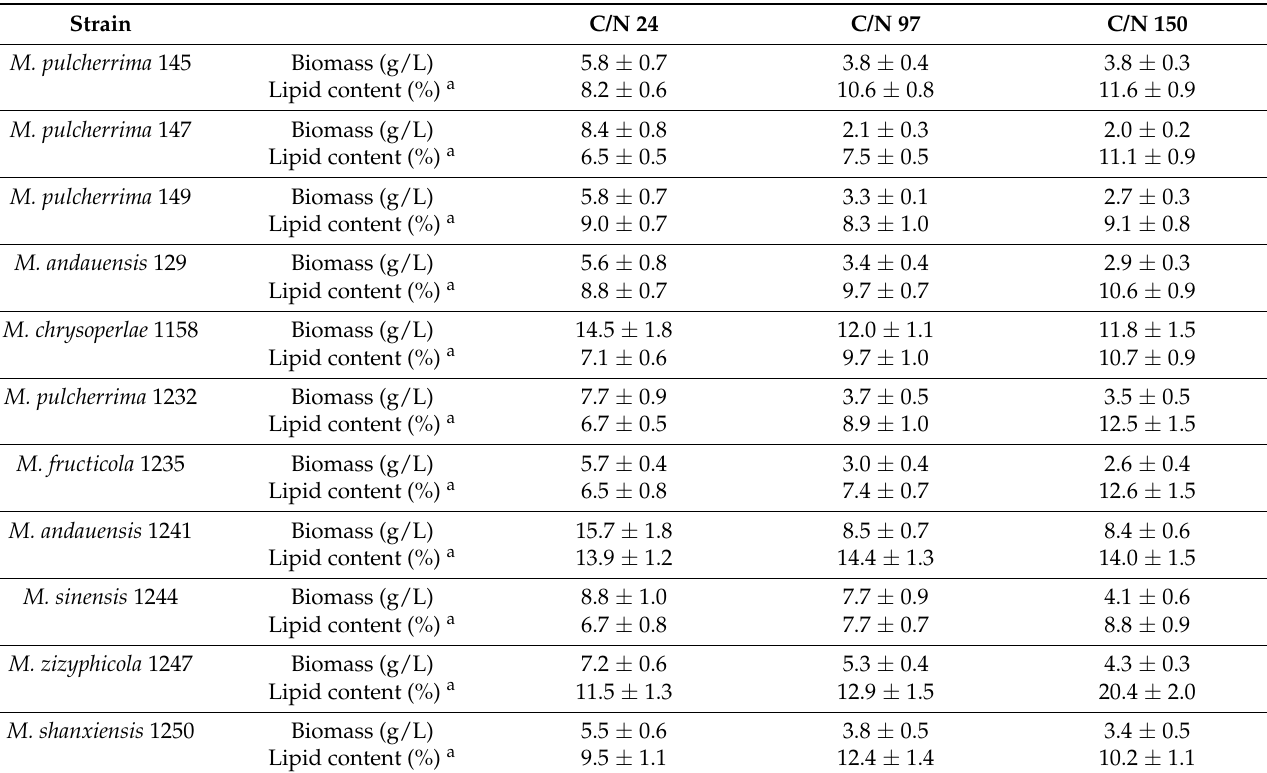
Table 7. Production biomass and lipids at low temperature cultivated on crude animal fat medium with different C/N ratio. Strain C/N